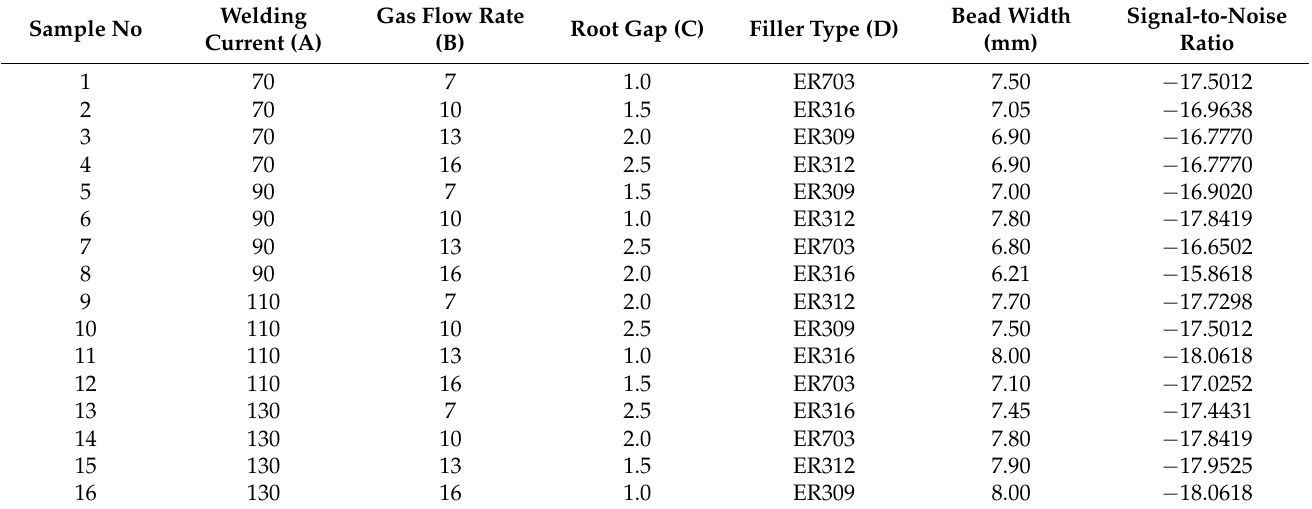
Table 19. The experimental results of Bead width.